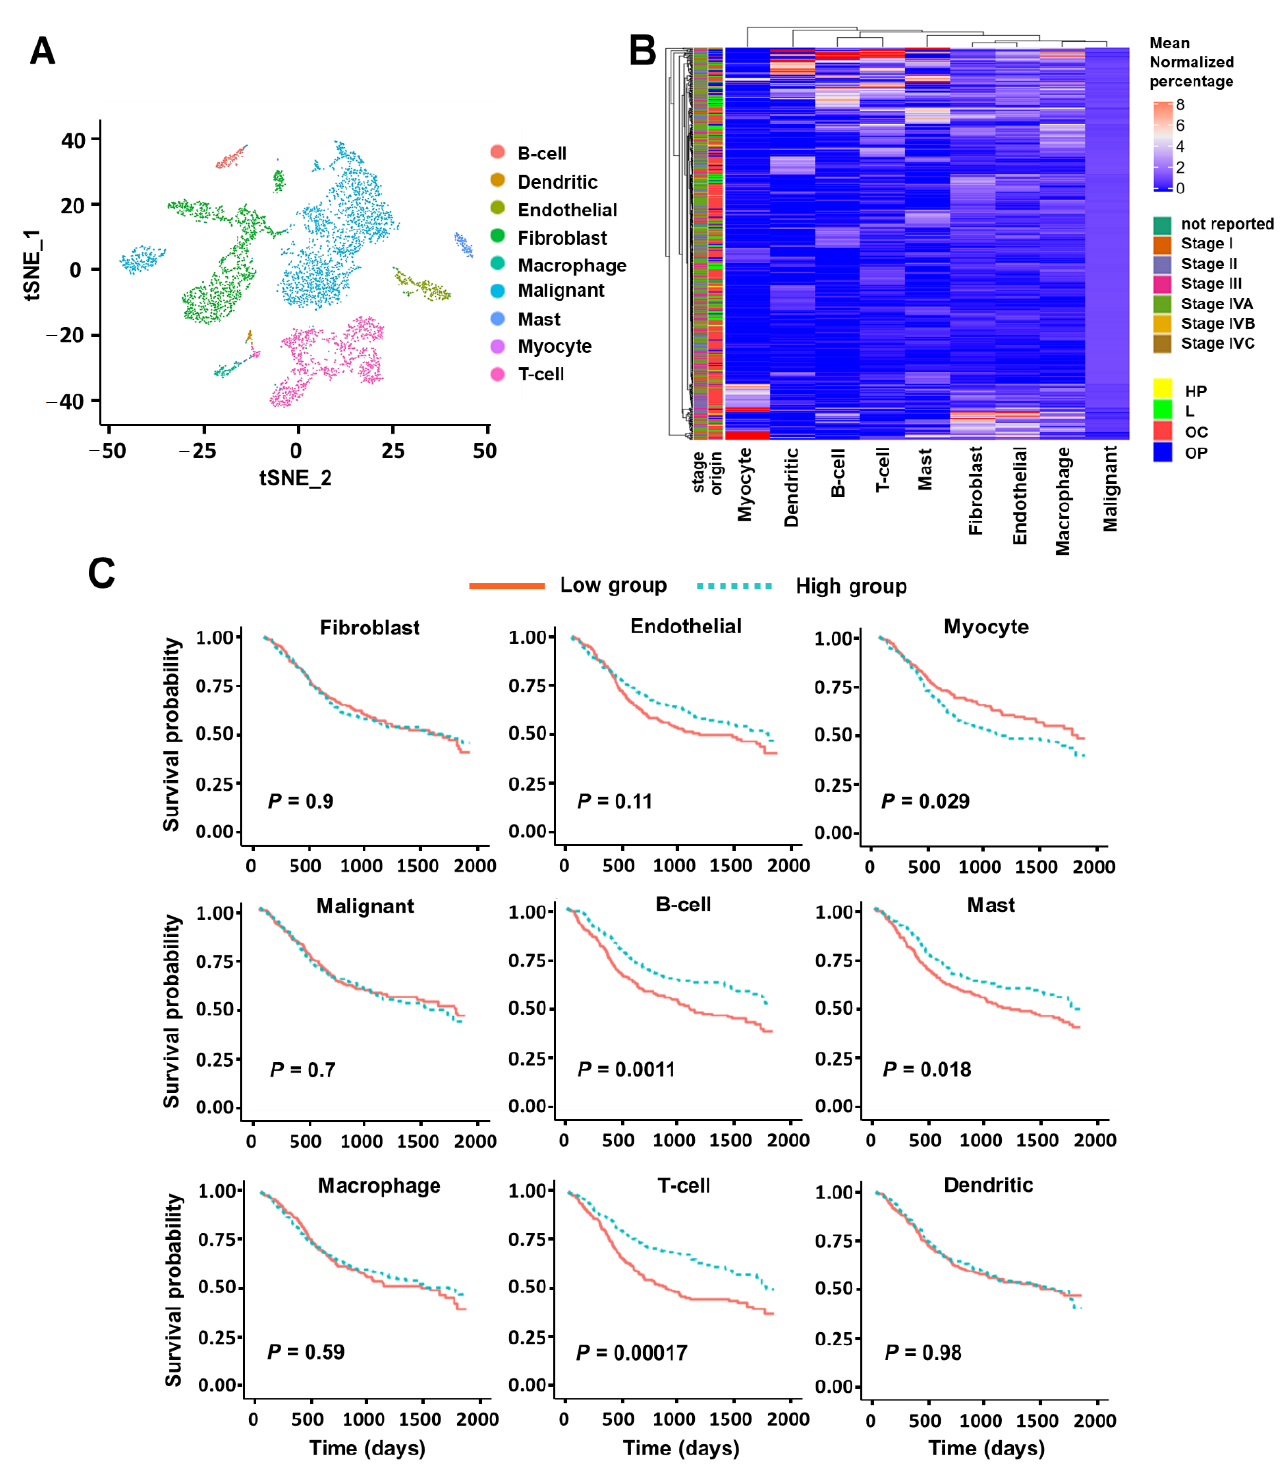
Figure 2. CIBERSORTx analysis with scRNA-seq reference of nine major cell types. ( A ) t-SNE projection of scRNA-seq data from 21 HNSCC samples colored by nine major cell clusters. ( B ) Heatmap of the relative cell fractions of the nine major cell types for each sample estimated by CIBERSORTx. The percentage is normalized by the corresponding mean within each cell type. The tissue origin and tumor stage are annotated as side bars. (HP = Hypopharynx; L = Larynx; OC = Oral Cavity; OP = Oropharynx). ( C ) Association between cell proportions and overall survival in patients with HNSCC profiled by TCGA. Estimated cell proportions were stratified by a half–half split, and the separation between survival curves was evaluated using a log-rank